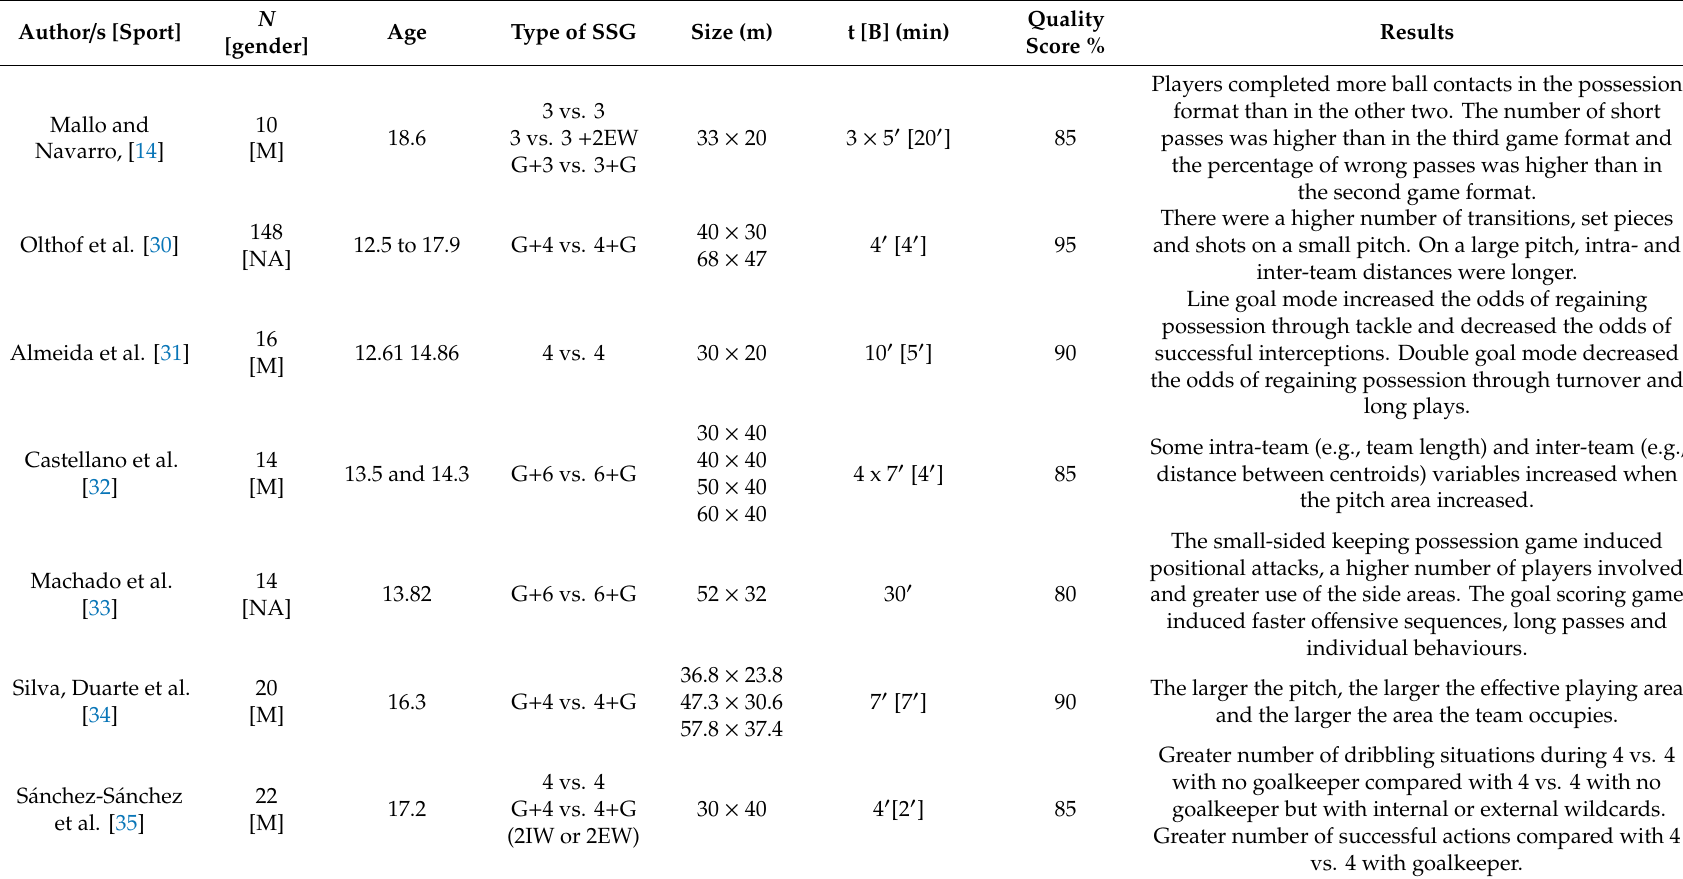
Table 1. E ff ects of small-sided games (SSGs) on technical-tactical aspects in